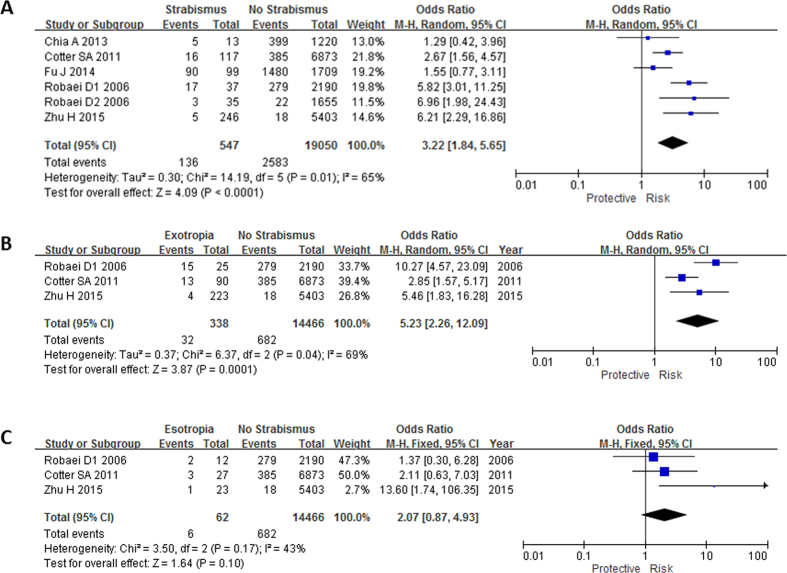
Meta-analysis of the association of myopia with different types of strabismus.The bars with squares in the middle represent 95% confidence intervals (95% CIs) and odds ratios (ORs). The central vertical solid line indicates the ORs for the null hypothesis. Diamond indicates summary OR with its corresponding 95% CI. (A) Association between myopia and strabismus. (B) Association between myopia and exotropia. (C) Association between myopia and esotropia.